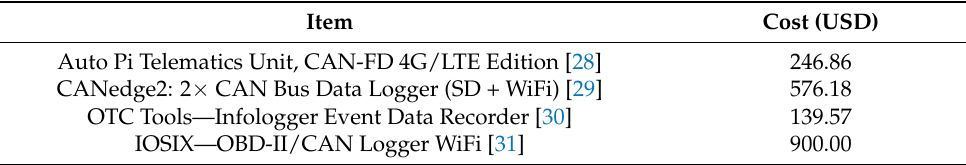
Table 1. Costs of commercially available OBD-II data